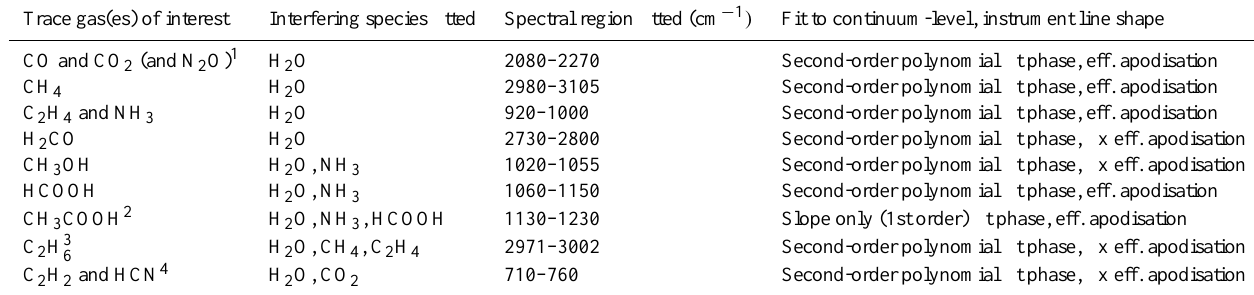
Table 1. Spectral regions used for trace gas retrievals and trace gas species fitted.